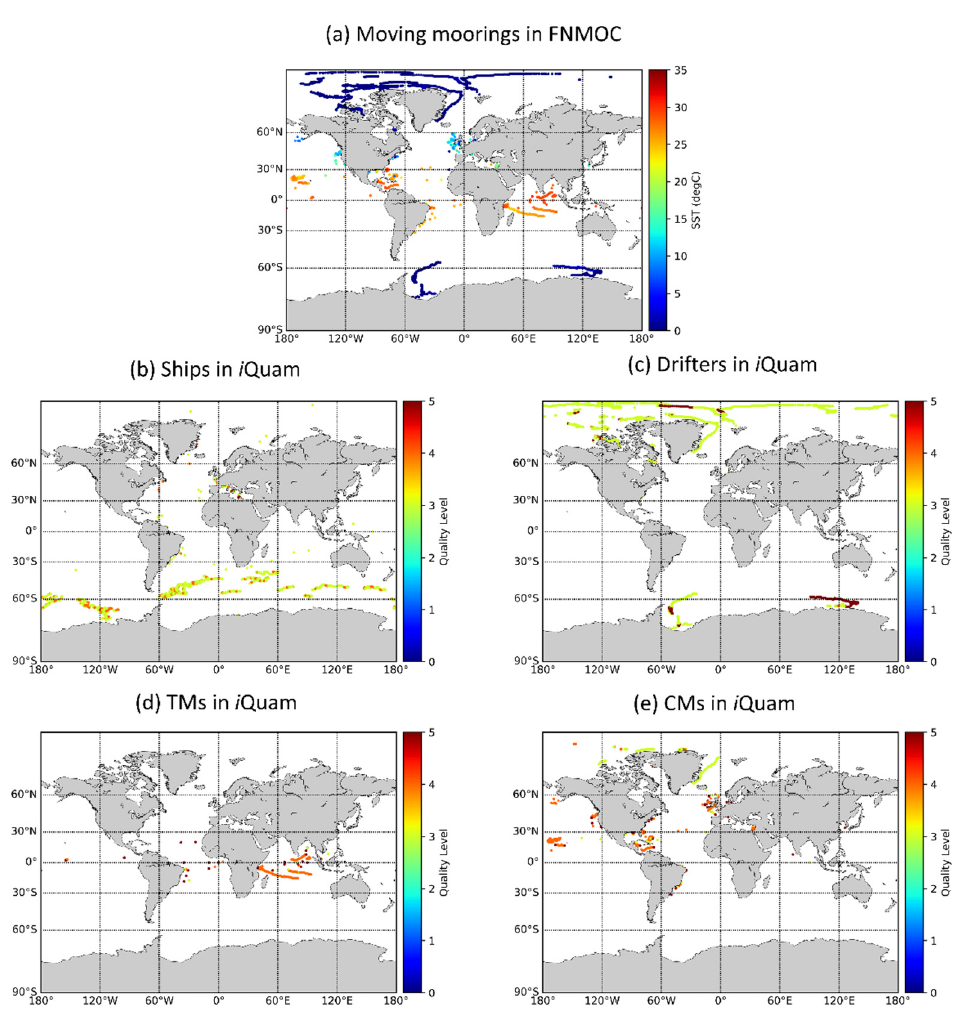
Figure 7 . ( a ) The ‘moving moorings’ in FNMOC. The color bar in panel ( a ) indicates SST. These moorings have been (re)classified in i Quam as ( b ) ship, ( c ) drifting buoys, ( d ) tropical moorings, and ( e ) coastal moorings. Note the color bar in panels ( b – e ) represents the i Quam quality levels. The TM SSTs are generally considered to be more precise than CM SSTs (e.g., in [32] and references therein), and more widely used in satellite SST Cal/Val and DA. The following analyses will focus on TMs only. Table 4 displays the number of TM UIDs and Nobs. The UID counts found in all data sets are very close. Out of the ~100 UIDs, 98 are shared by all three data sets. However, the Nobs vary from one source to another. The ICOADS has ~1.03 million records, CMEMS >5 million, and FNMOC ~0.85 million.